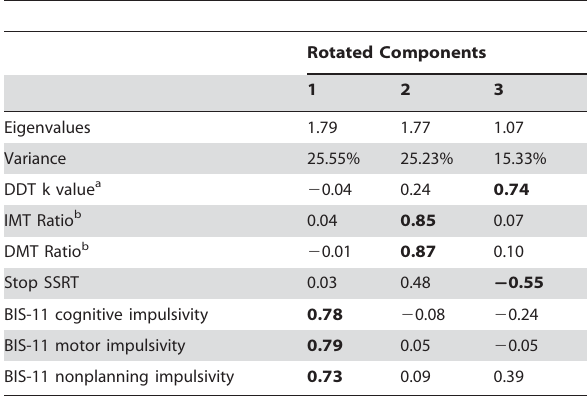
Table 1. Principal component analysis yielding 3 rotated components (N =100)